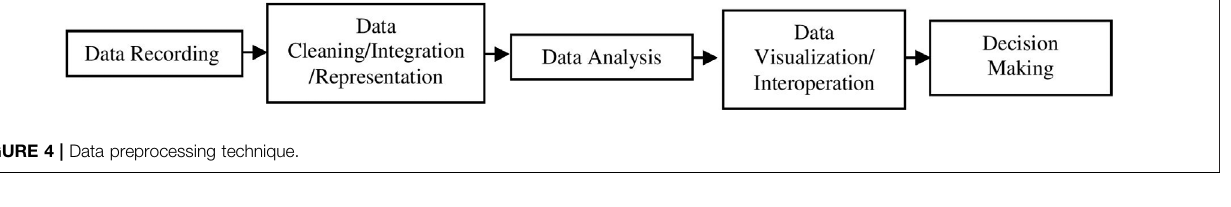
Frontiers in Built Environment |